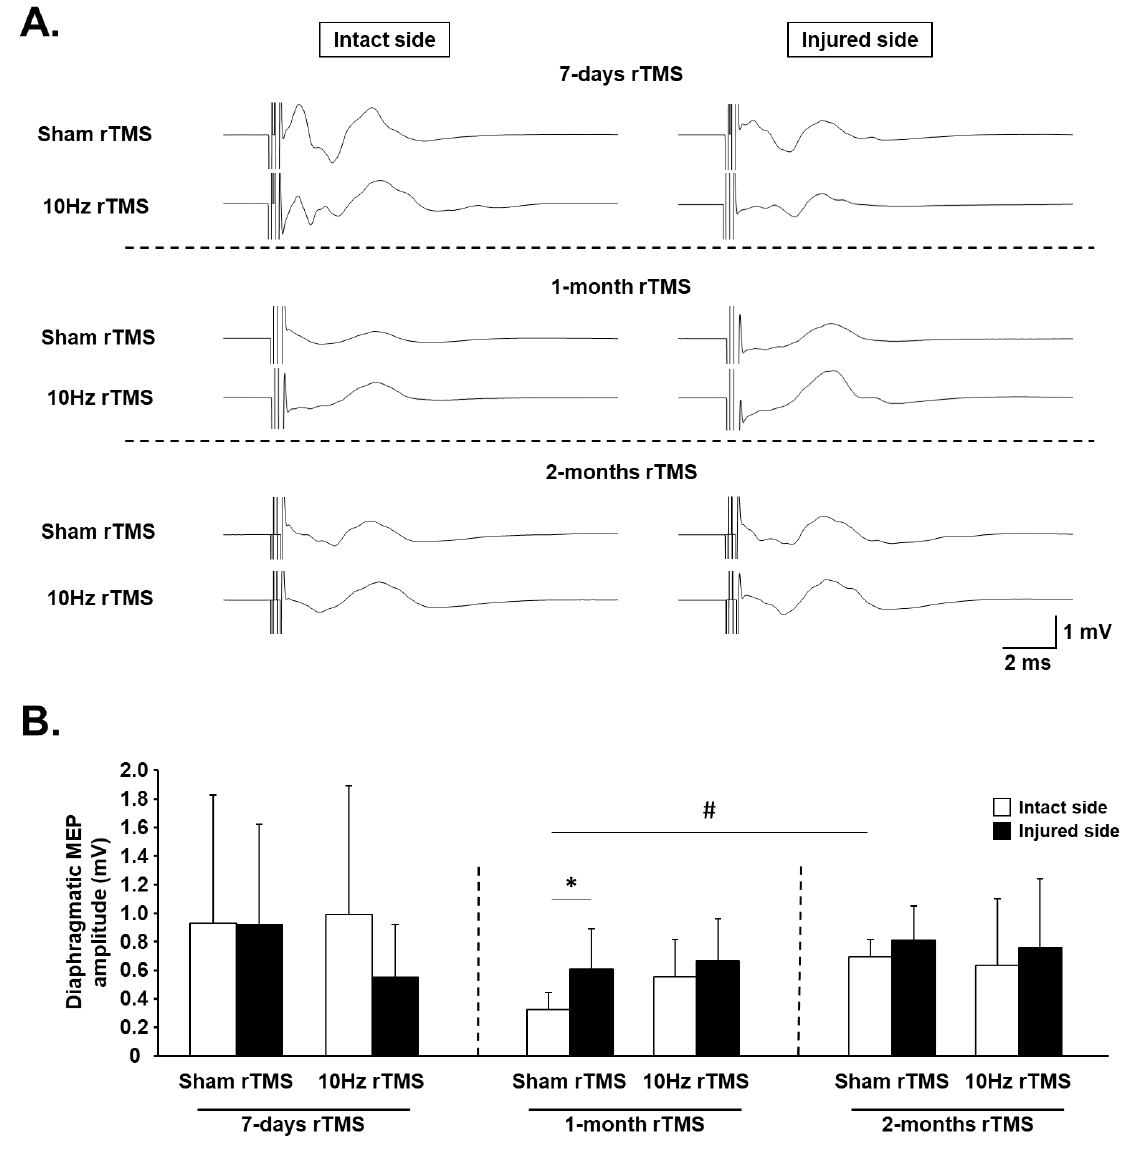
Figure 5. Diaphragm excitability in C2 hemisected rats following chronic Sham and 10 Hz rTMS :